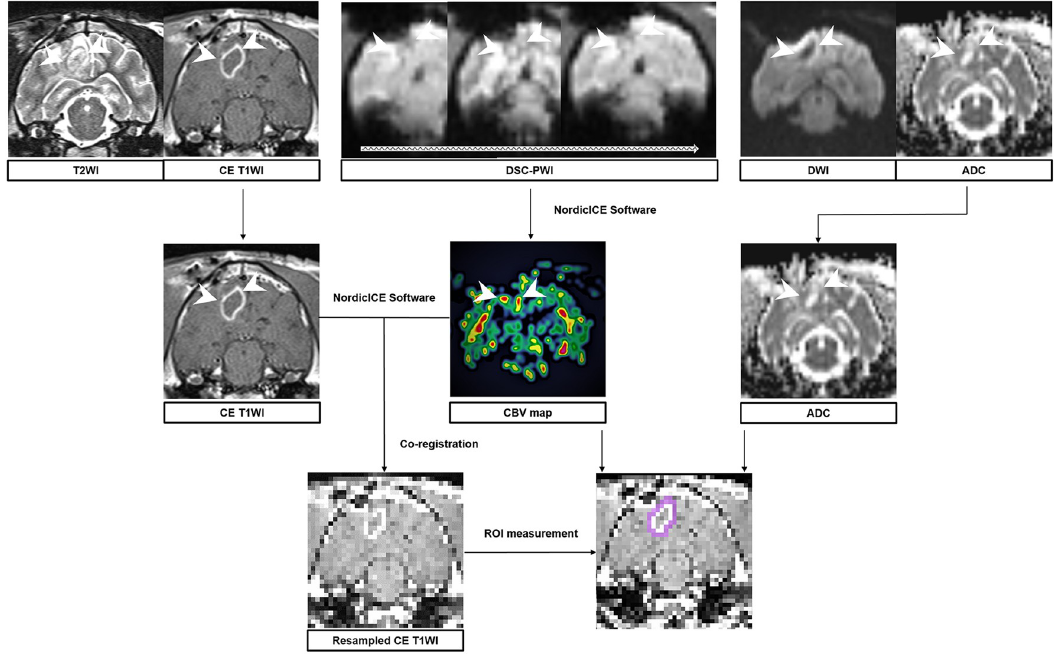
Fig 2. Flow chart of the quantitative image analysis. Flow chart of the quantitative image analysis. A region of interest (ROI) was manually selected in each section of the enhancing lesions and semiautomatically coregistered with the relative cerebral blood volume map (rCBV) and coronal contrast-enhanced T1-weighted images. The volume of interest is determined by the summation of the ROIs from each slice; the rCBV values and apparent diffusion coefficient (ADC) values for the entire enhancing lesion are obtained. The relative perfusion values and ADC values in the normal-appearing white matter and cerebellum are also derived. The normalized perfusion values and ADC values were calculated by dividing each tumour and normal-appearing white matter by the corresponding cerebellar